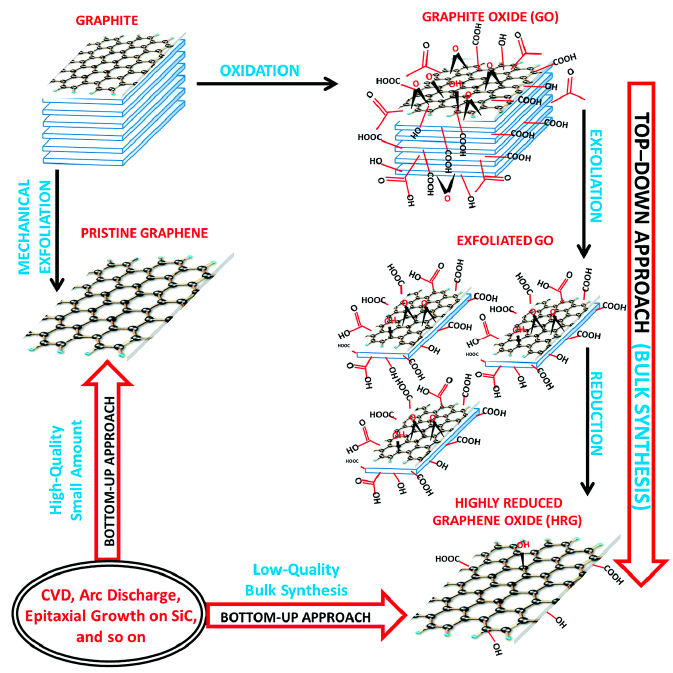
Figure 1. Graphene derivatives, graphene oxide and reduced graphene oxide [29] (copyright 2015, Journal of Materials Chemistry—A).